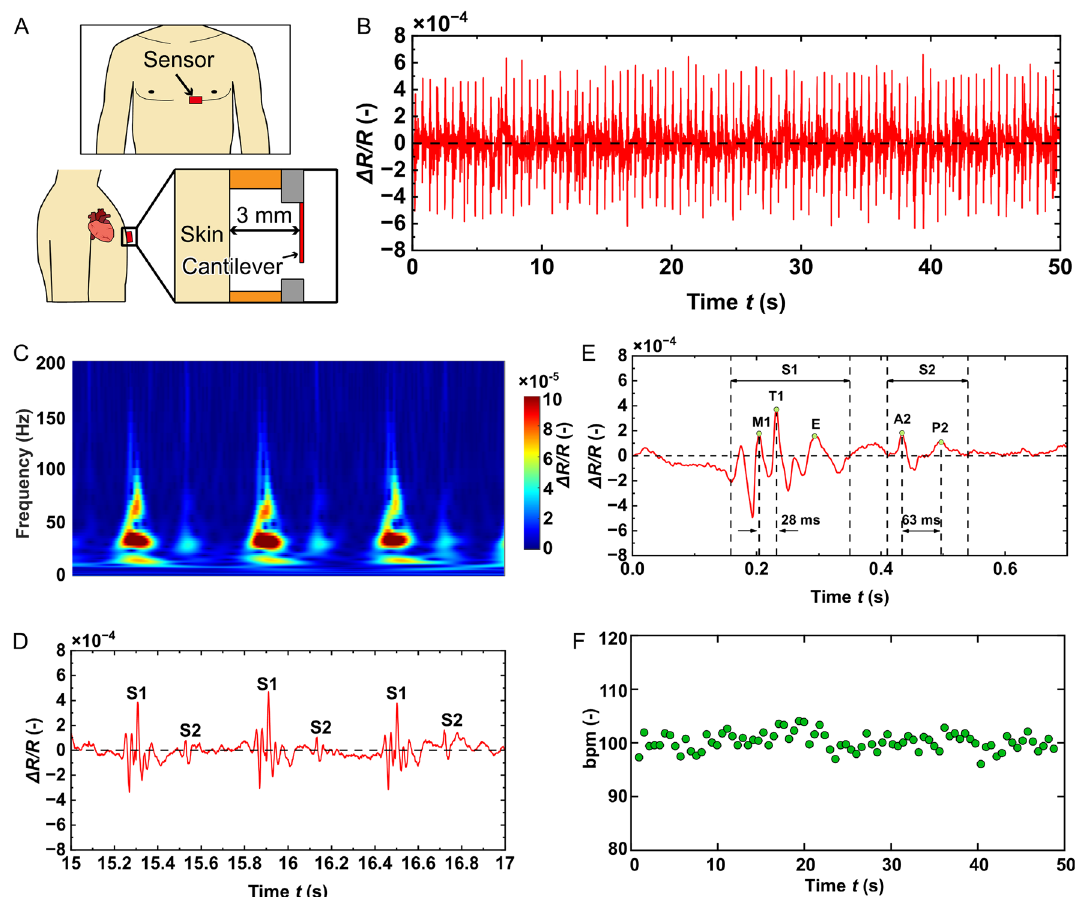
Figure 7. ( A ) Conceptual schematic of the proposed sensor for measuring heart sound. ( B ) Raw data of the pulse sound measurement. ( C ) Wavelet scalogram of the recorded heart sound in the duration of 15–17 s. ( D ) A zoomed-in view of the recorded heart sound in the duration of 15–17 s. ( E ) A zoomed-in view of a single cycle of the heart sound. ( F ) Heart rate of the subject for each individual heartbeat.